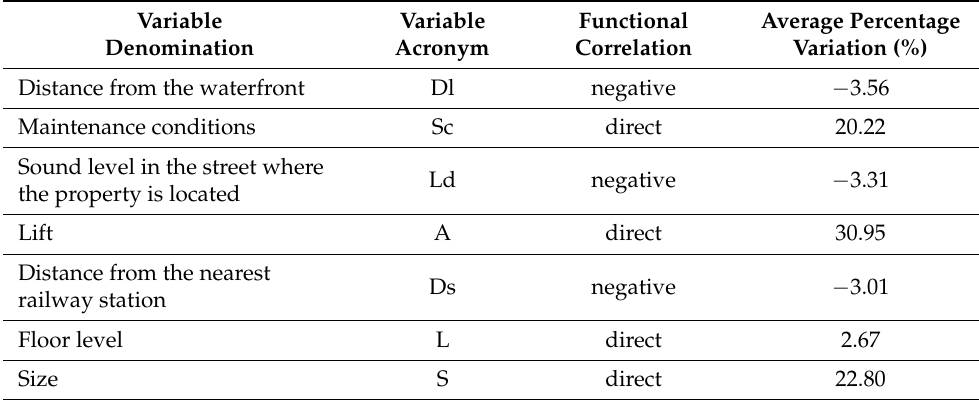
Table 3. Total selling price average percentage variation for the variables chosen by the model for the OMI central area of the city of Bari.